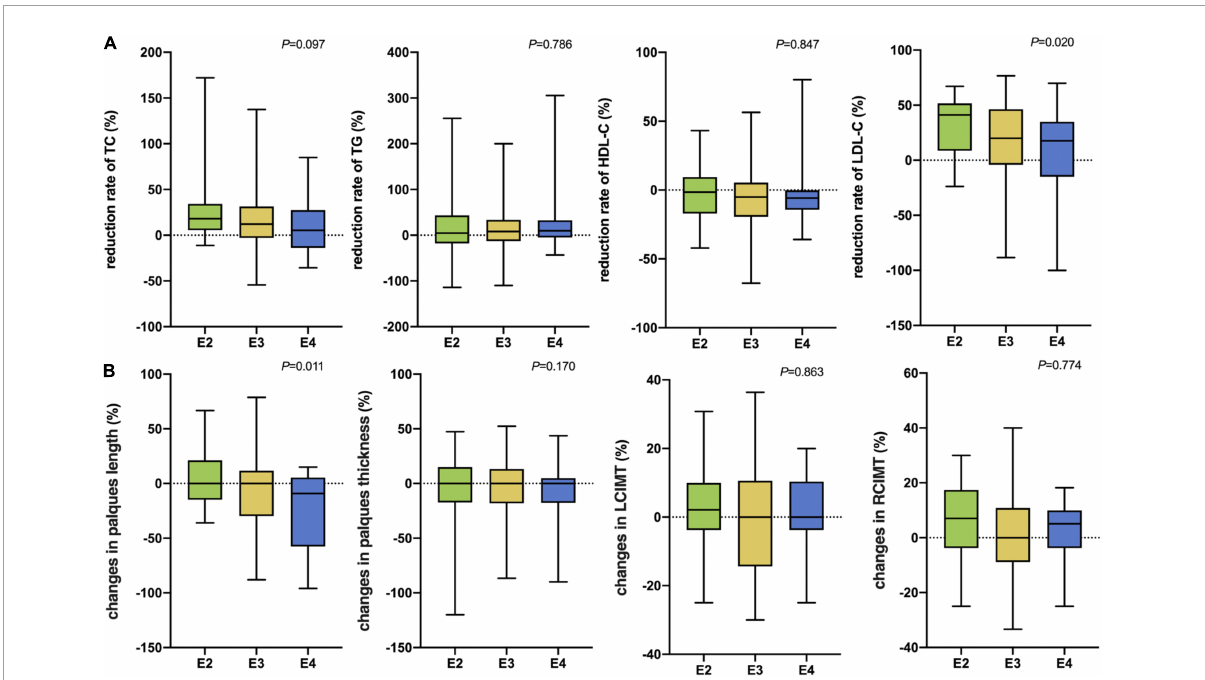
FIGURE2 (A) The rate of reduction in blood lipids after 3 months of atorvastatin treatment in the three groups. (B) Changes in carotid plaque size after 12 months of atorvastatin treatment in the three groups. TC, Total cholesterol; TG, Triglyceride; HDL-C, High-density lipoprotein cholesterol; LDL-C, Low-density lipoprotein cholesterol; LCIMT, Left carotid intima-media thickness; RCIMT, Right carotid intima-media thickness.